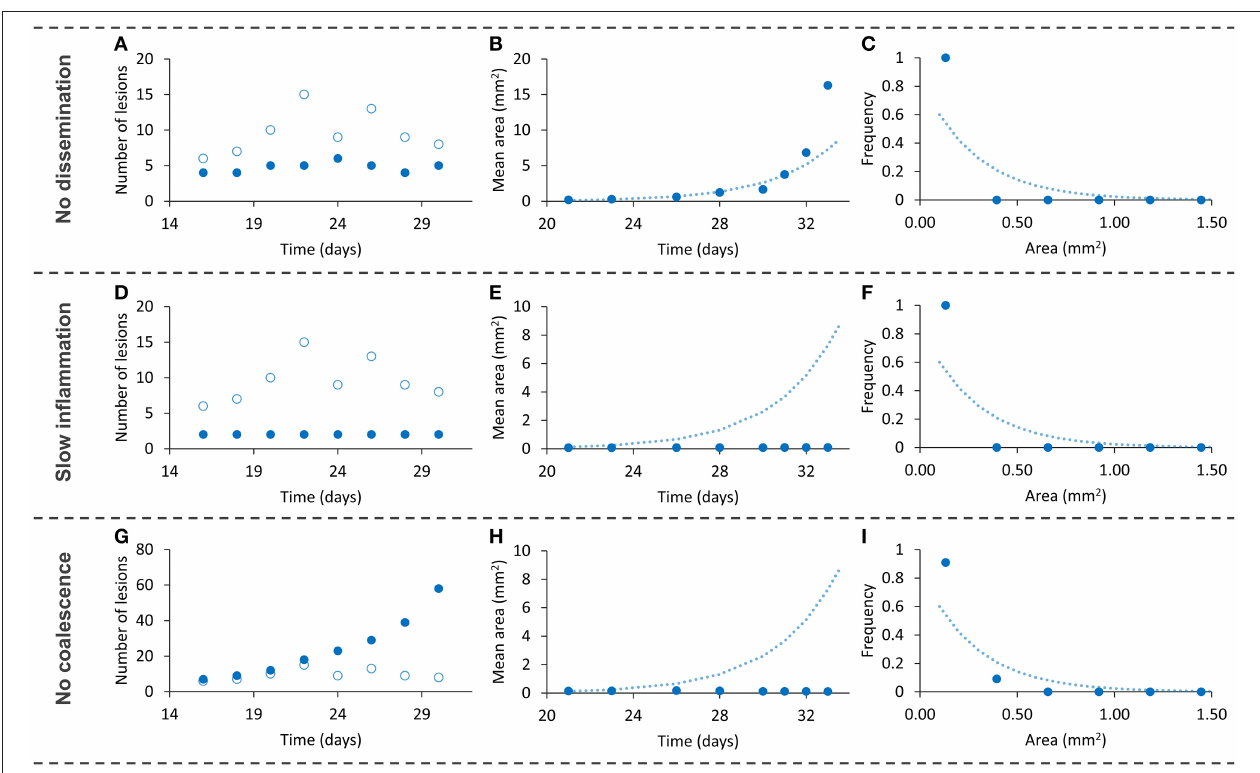
FIGURE 6 | Dynamics of the three variables studied (number of lesions—left, mean area evolution—center, area distribution at day 21—right) when removing one of the hypotheses from the model [no dissemination—top (A–C), slow inflammatory response—middle (D–F), no coalescence—bottom (G–I)]. Light empty symbols and dotted lines correspond to the results obtained with the complete model, using parameters of panel A ( Table 1 ). Figures 6E,H are enlarged in Figure 7 .